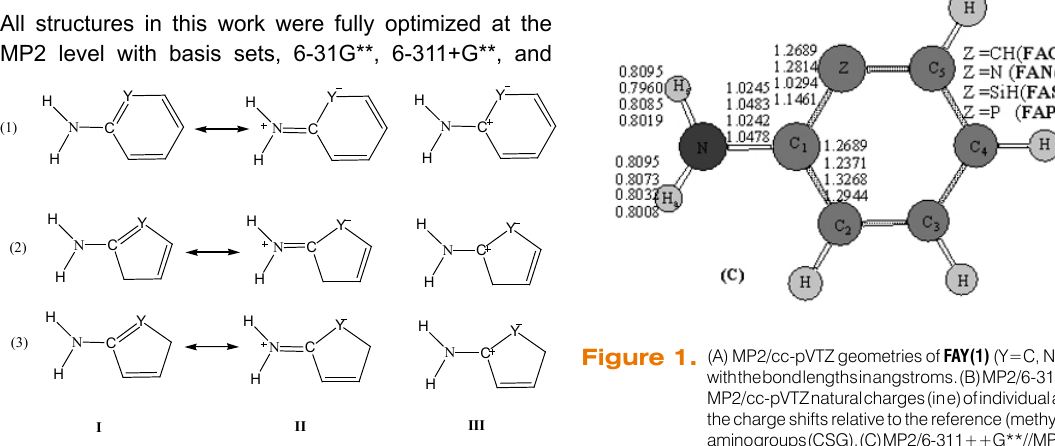
Scheme 1. The resonance effect among the C, N, and Y atoms